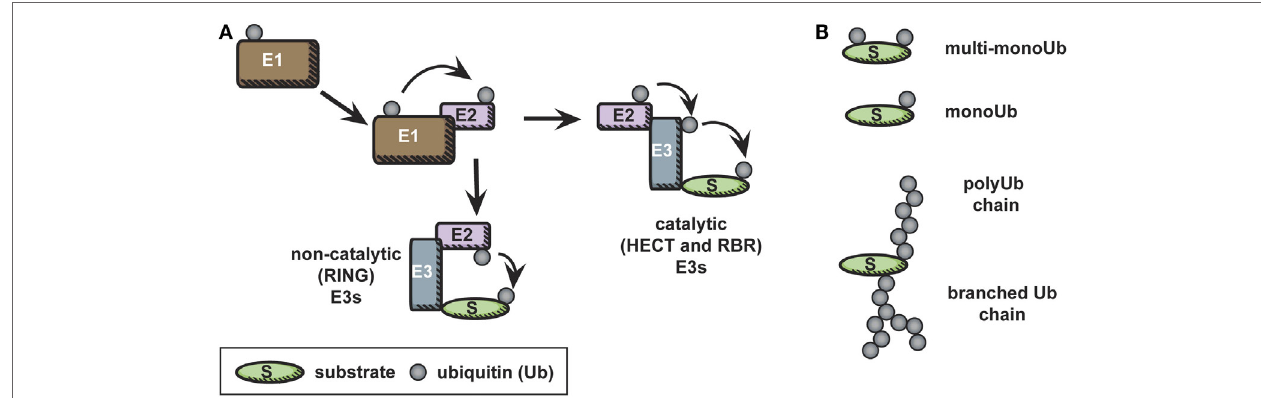
FiGURe 1 | The ubiquitin cascade . (A) Free ubiquitin is activated in an ATP-dependent manner by conjugation to an E1. Subsequently, in a trans-thiolation reaction, ubiquitin is transferred from the E1 to the catalytic cysteine of an E2. The ubiquitin-conjugated E2 then interacts with an E3 ubiquitin ligase, to allow ubiquitylation on a lysine residue of a substrate. In the case of catalytic E3 ligases, an additional trans-thiolation reaction occurs to transfer ubiquitin from the E2 catalytic cysteine to the E3 catalytic cysteine. The E3 then mediates covalent bond formation between the substrate and ubiquitin. (B) Ubiquitylation is a diverse modification, and distinct types of ubiquitylation – monoubiquitylation, multi-monoubiquitylation, and various polyubiquitylation linkages – are recognized by distinct ubiquitin-binding domains, leading to diverse final outcomes for the ubiquitylated